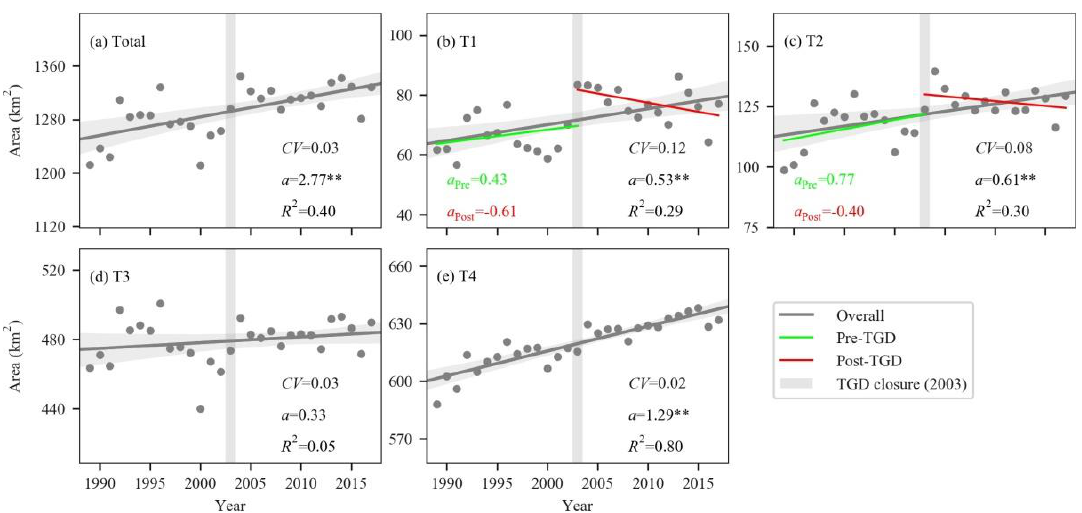
Figure 9. Area temporal dynamics of different groups of MCBs: ( a ) Total MCBs, ( b ) T1 MCBs, ( c ) T2 MCBs, ( d ) T3 MCBs, and ( e ) T4 MCBs. The regression parameters a and R 2 stand for regression slope and coefficient of determination. Slope values with “*” and “**” indicate the corresponding p -value < 0.05 and < 0.01, respectively. The CV stands for coefficient of variation which is defined as the ratio of the standard deviation to the mean and here it indicates the extent of variability in relation to the mean area of the MCBs.